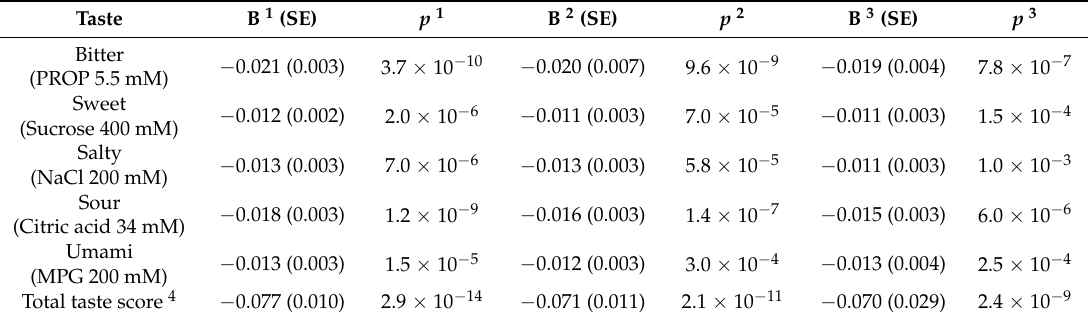
Table 3. Association between age (in years) and taste perception in the whole